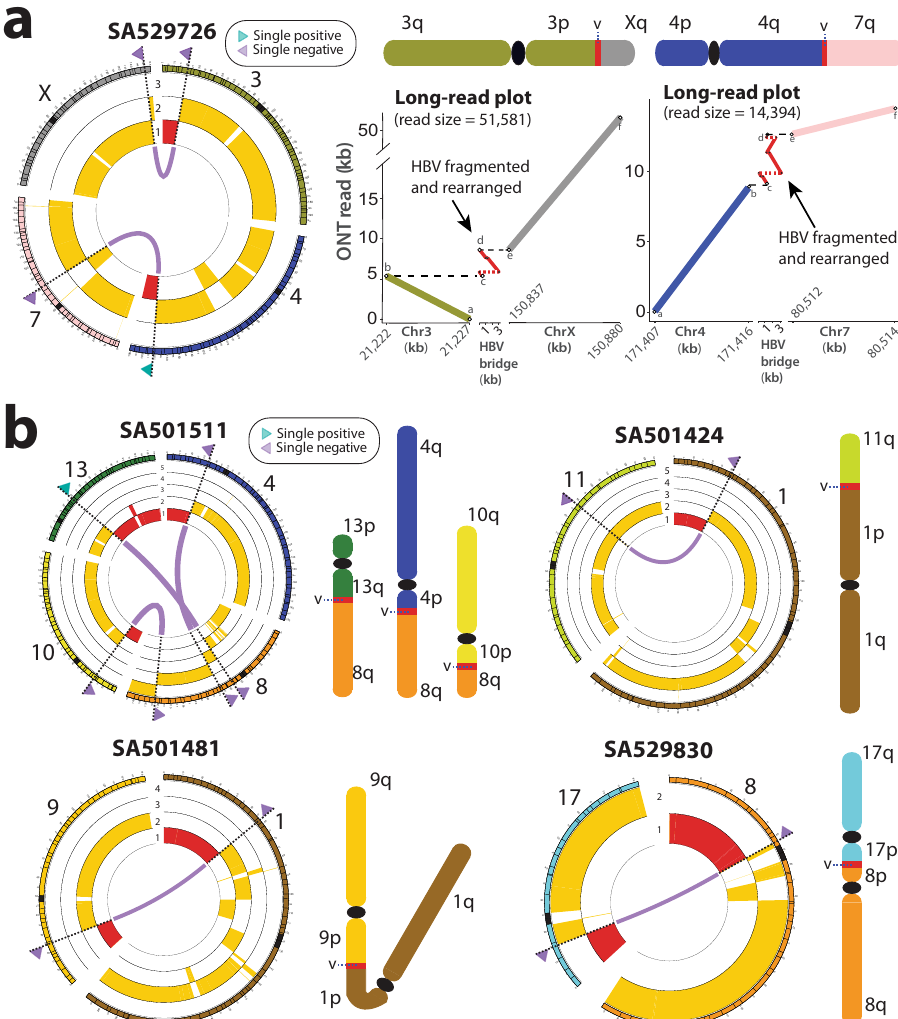
Fig. 3 HBV DNA integration mediates interchromosomal genomic rearrangements that lead to megabase-size telomeric deletions in HCC. a In tumour SA529726, two unrelated HBV-mediated interchromosomal rearrangements between chromosomes 3 and X, and between chromosomes 4 and 7, promote 21.2 Mb and 19.8 Mb telomeric deletions on the 3p and the 4q, respectively. The circos plot (left) represents the translocations (purple lines) revealed by ONT data. Single clusters identi fi ed with paired-end mapping data are denoted as triangles (green for positive orientation, purple for negative) on the chromosome ideograms. The copy number pro fi les are shown in yellow below the chromosome ideograms, with relevant telomeric deletions highlighted in red. The long-read plots (right) represent the alignment of one ONT long-read to chromosomes 3 and X, and chromosomes 4 and 7, of the human reference genome and an HBV consensus sequence, which validates the interchromosomal rearrangements mediated by the virus shown in the circos plot. Here, the analysis of the long-reads supporting the HBV events showed an HBV DNA insertion in a classical fragmented and rearranged form 5, 17 . The expected con fi guration of the rearranged chromosome is shown above each long read plot (the ideograms are for illustrative purpose only); ‘ v ’ denotes the HBV insertion. The long-reads used to construct the long-read plots are annotated in Supplementary Table 1. b Circos plots and chromosome diagrams of similar HBV-mediated non-homologous translocations promoting megabase-size telomeric deletions in four additional HCC tumours. Again, the expected con fi guration of the rearranged chromosome is shown next to each circos (the ideograms are for illustrative purpose only). In SA501511, three unrelated HBV-mediated translocations involving different loci on chromosome 8 promote huge deletions involving telomeric regions on chromosomes 13q, 4p and 10p. In SA501424, one HBV insertion bridges a genomic translocation between chromosomes 1 and 11 that generates a terminal deletion at 1p. In SA501481 and SA529830, HBV-mediated translocations generate dicentric chromosomes and promote megabase-size terminal